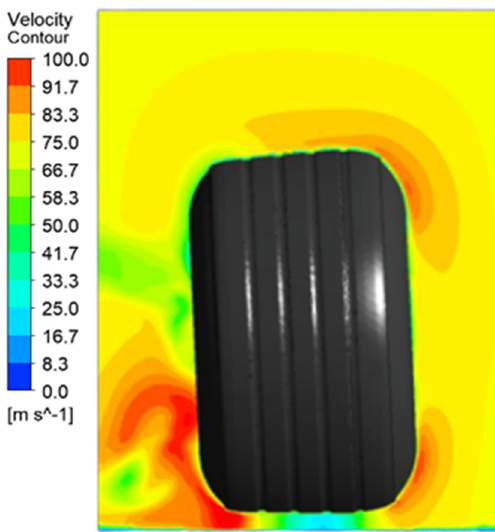
Figure 6. Control plans for post-processing.